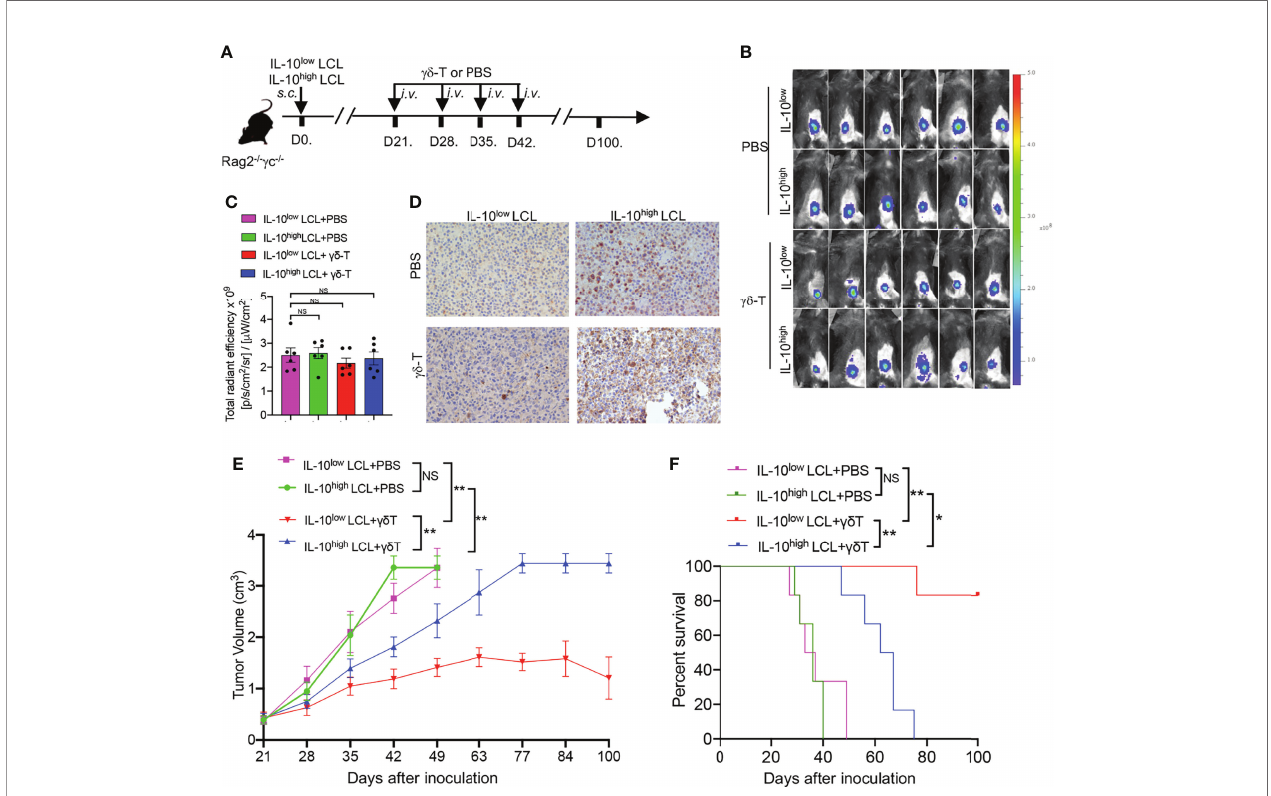
FIGURE 2 | Antitumor activity of V g 9V d 2-T cells against EBV-induced lymphoma was decreased under IL-10 high TME in vivo . (A) IL-10 low LCL and IL-10 high LCL were injected s.c. in Rag2 − / − g c − / − mice separately. After 21 days, mice that had developed subcutaneous tumor were randomly divided into two groups respectively followed by the treatment with allogeneic V g 9V d 2-T cells or PBS at indicated time (six mice per group). (B, C) Whole-body fl uorescence images (B) and total radiant ef fi ciency (C) of mice before treatment with V g 9V d 2-T cells or PBS. (D) Representative histology of IL-10 in tumor sections that developed from IL-10 low LCL and IL- 10 high LCL. (E, F) The tumor volume (E) and mouse survival (F) were determined at the indicated time. The tumor volume was compared using two-way ANOVA analysis, and mice survival was compared using Kaplan-Meier log-rank test. Data are representative for three independent experiments. *p < 0.05; **p < 0.01; ns, no signi fi cant